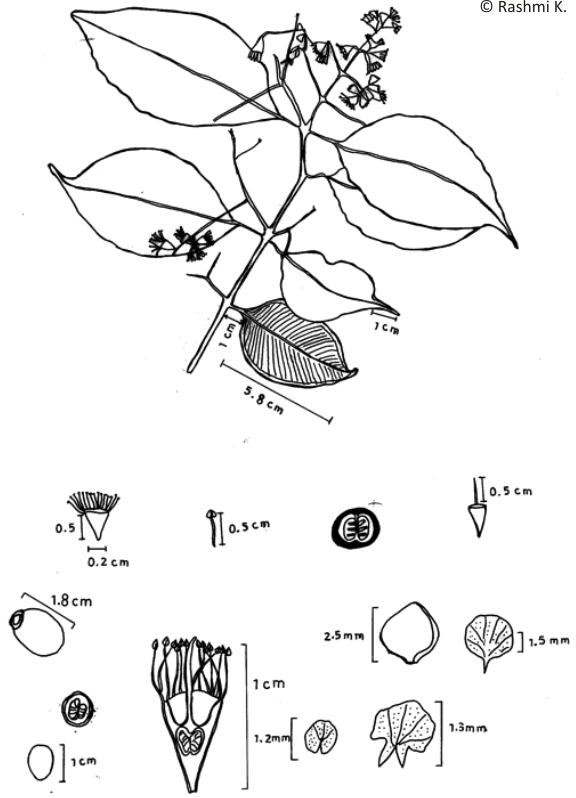
Figure 1. Syzygium kanarense (Talbot) Raizada. A - Habit; B - Flower; C - L.S of Flower; D - Sepal; E–G - Petals; H - Androecium; I - Gynoecium; J - T.S of Ovary; K - Fruit; L - Seed.